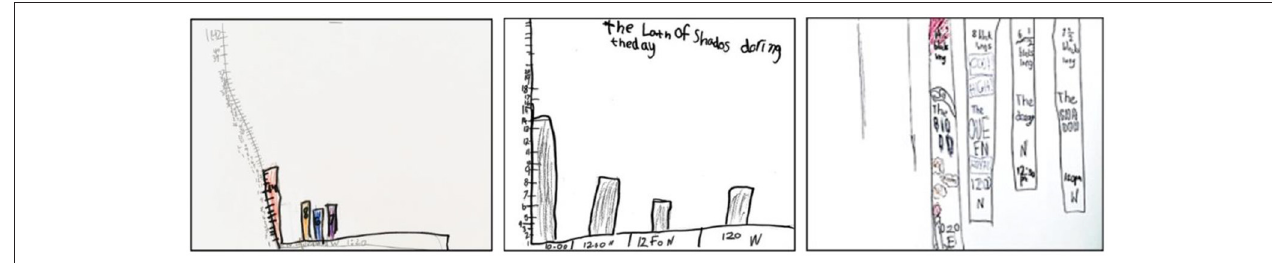
FIGURE 12 | Examples of students’ graphical representations of the shadow changes. a range of sample plots, and finally the astronomy sequence).